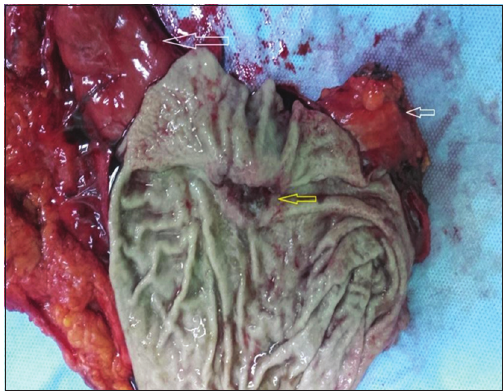
FIGURE 2. Macroscopic examination shows ulcerated tumor at the anastomosis line (large arrow: efferent loop; small arrow: affer- ent loop; yellow arrow: